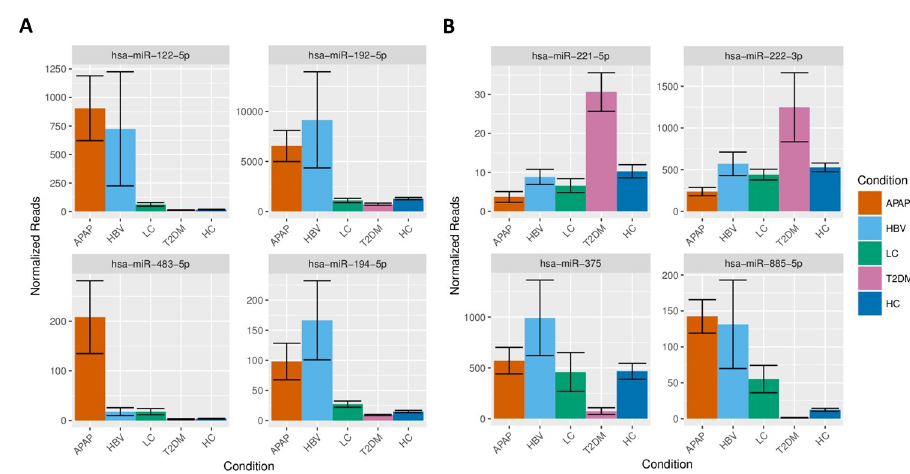
Fig 4. Serum levels of significant regulated miRNAs. The figure presents serum levels, based on normalized sequencing reads, of significantly altered miRNAs in APAP, HBV, LC, T2DM an HC for miR-122- 5p, miR-192-5p, miR-483-5p and miR-194-5p (A) and miR-221-5pp, miR-222-3p, miR-375and miR-885-5p (B).